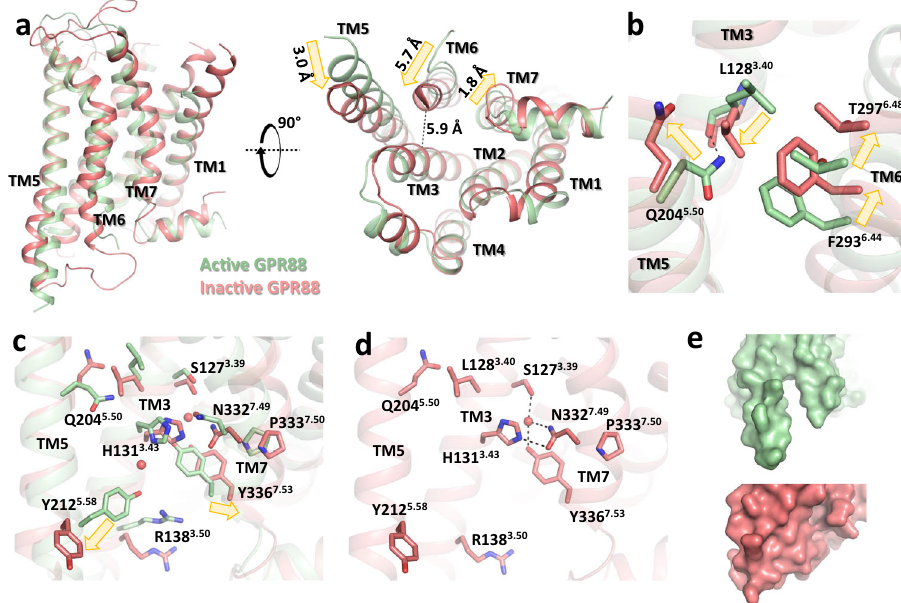
Fig. 4 Metadynamics simulations of inactive-state GPR88. a Comparison of overall structures of GPR88 in the inactive state (calculated, red) and the active state (cryo-EM, green). b , c Conformational changes of the Q5.50-L3.40-F6.44 triad ( b ) and the water-mediated hydrogen-bonding network ( c ) associated with receptor deactivation (yellow arrows), water molecules of the active cryo-EM shown as red spheres. d Polar networks of the inactive conformation (calculated). e Comparison of the surfaces of the allosteric pocket of inactive and active states. The PDB fi le of the calculated inactive GPR88 model is provided as Supplementary Data 1. Source data are provided as a Source data fi